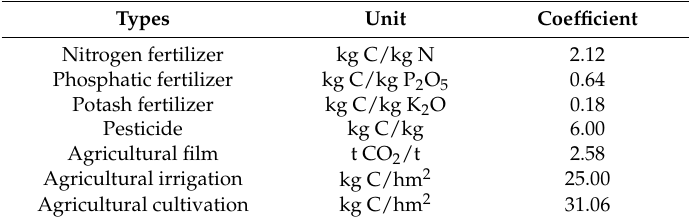
Table 1. Indirect carbon emission index for agricultural capital investment.